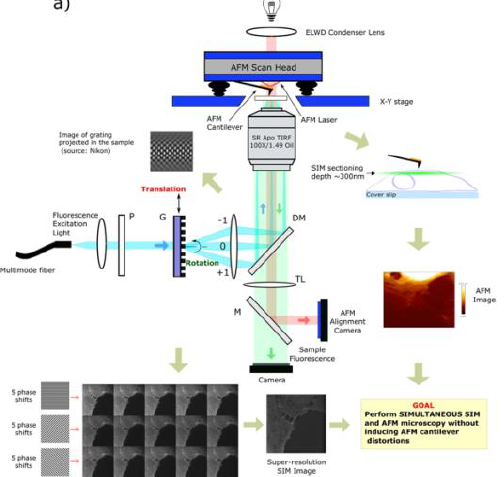
Fig. 1. Experimental set-up for the SR-SIM and AFM combined platform. Adapted from